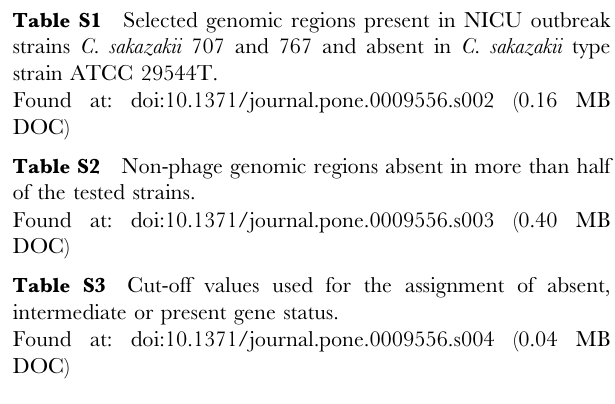
Figure S1 Absence/presence status of prophage genes in Cronobacter strains. Red indicates absence/divergence of a partic- ular gene, orange indicates uncertain status and green indicates presence of a gene. Table S1 Selected genomic regions present in NICU outbreak